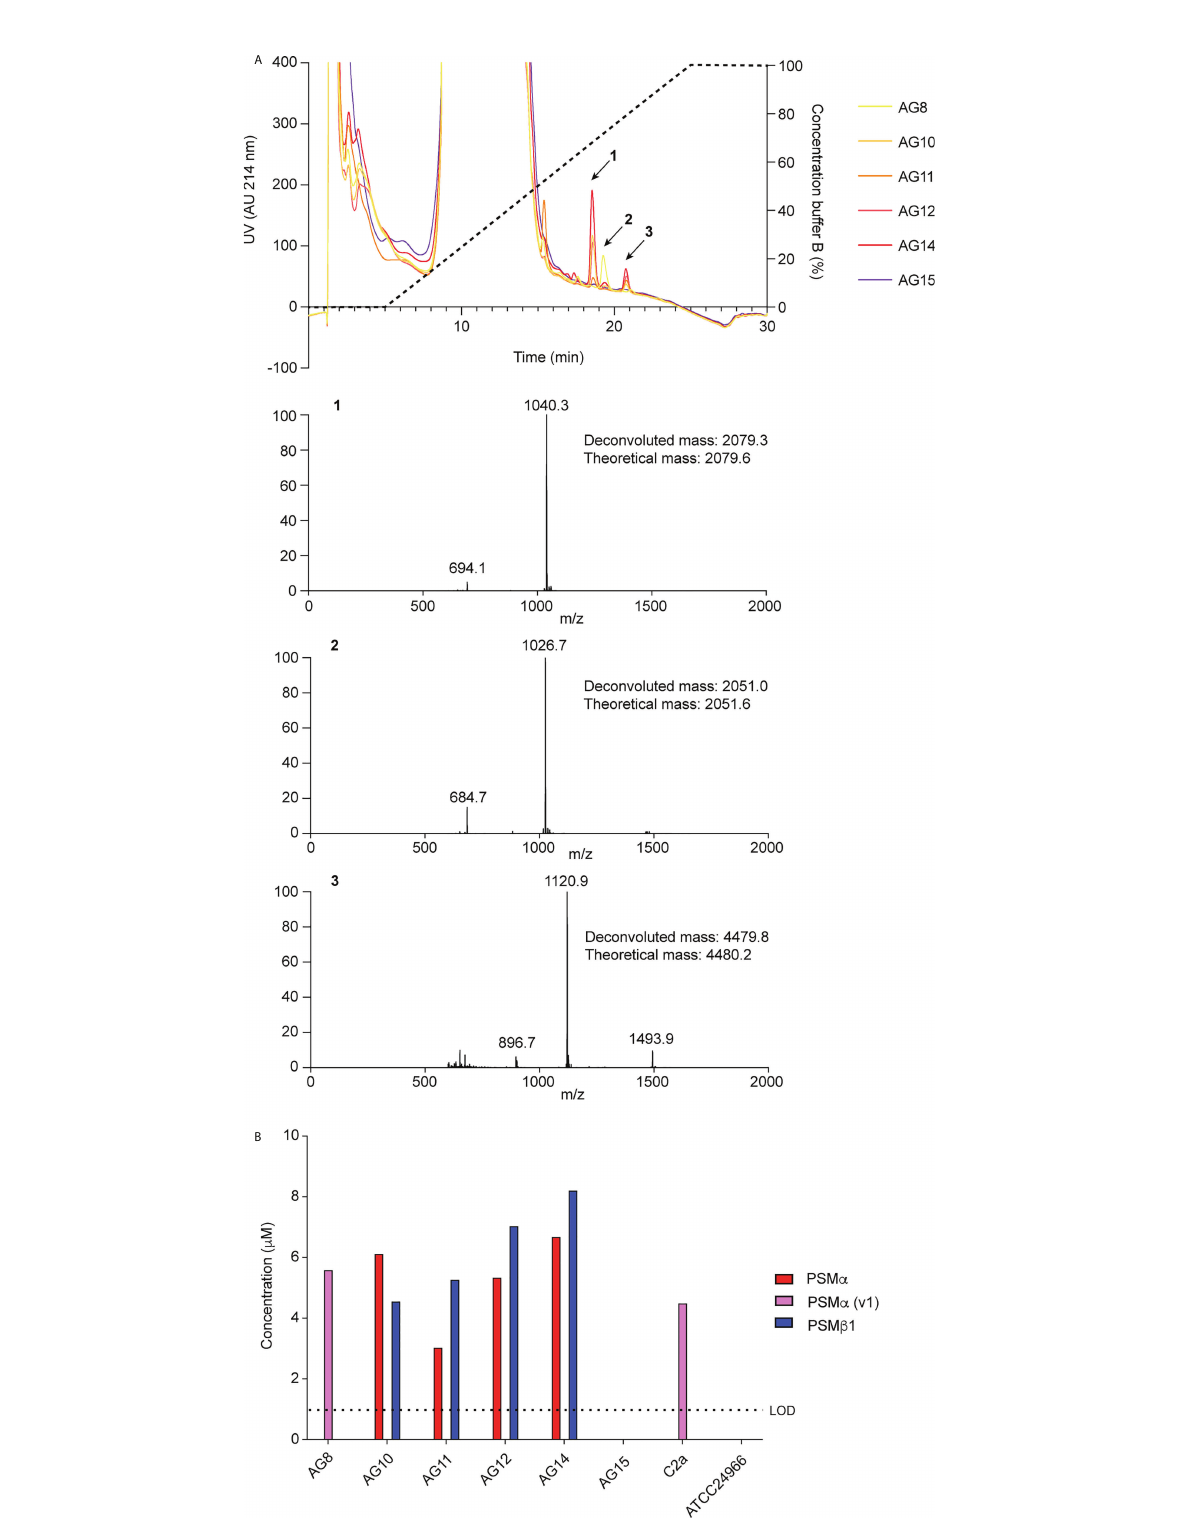
FIGURE 1 Detection of S. xylosus PSMs. (A) RP-HPLC/ESI-MS of culture fi ltrates of S. xylosus clinical isolates. Extracted mass spectra of peaks 1 to 3 are shown below the chromatogram. Results from deconvolution and theoretical average isotopic masses are noted. (B) Analysis of PSM production pattern by RP-HPLC/ESI-MS of culture fi ltrates collected from clinical S. xylosus isolates and reference strains. LOD, limit of